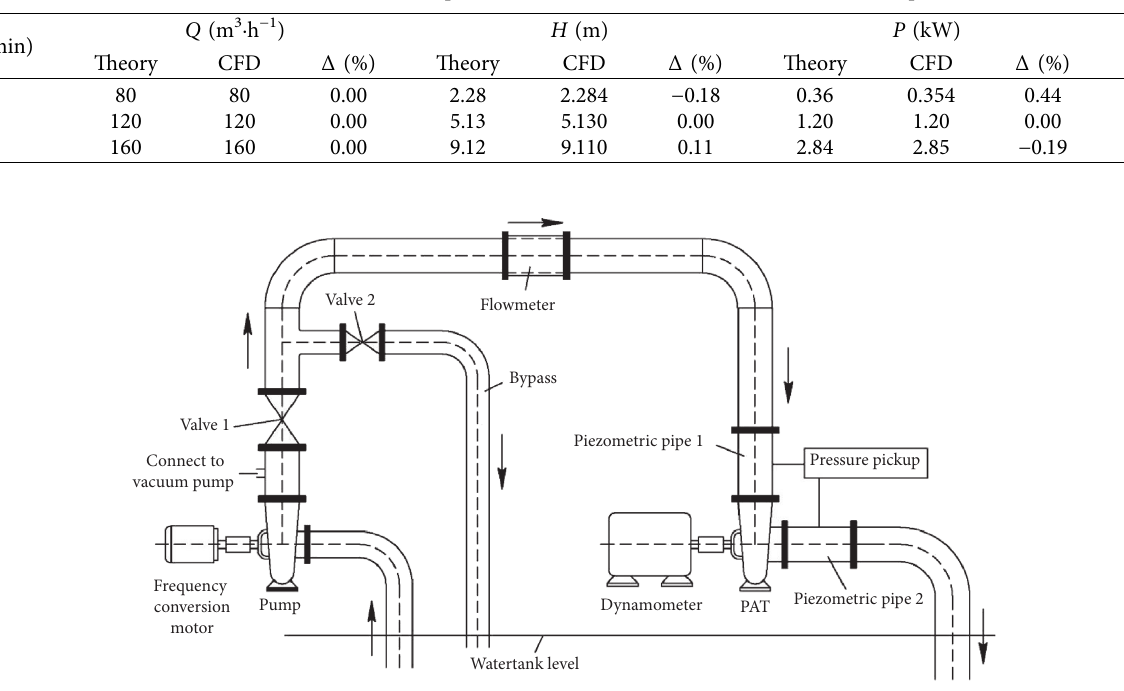
Figure 8: Schematic diagram of experiment rig.